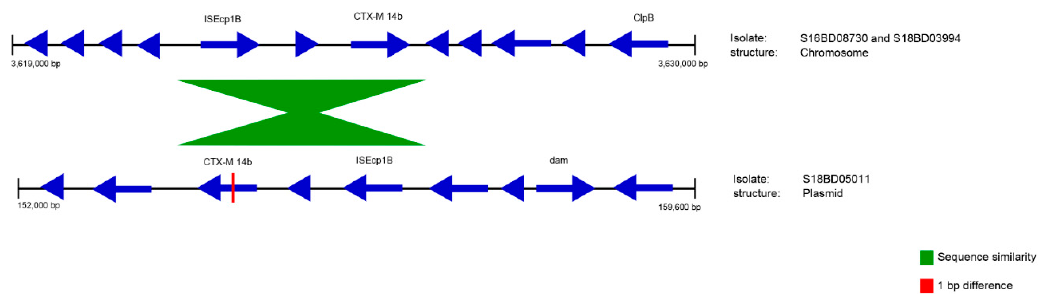
Figure 5. Similarity between the chromosomes of S16BD08730 and S18BD03394 and the plasmid of S18BD05011 (contig 2). The location and orientation of the genes is indicated with blue arrows. There is a 1 bp difference between the chromosomal and plasmid-located bla CTX-M14b gene. While the bla TEM-1B gene was also found in a chromosome (isolate S18BD00684) and a plasmid (contig 3 of isolate S18BD05011) of different isolates, the flanking regions were not similar. Therefore, it is unlikely that they are related to each other.